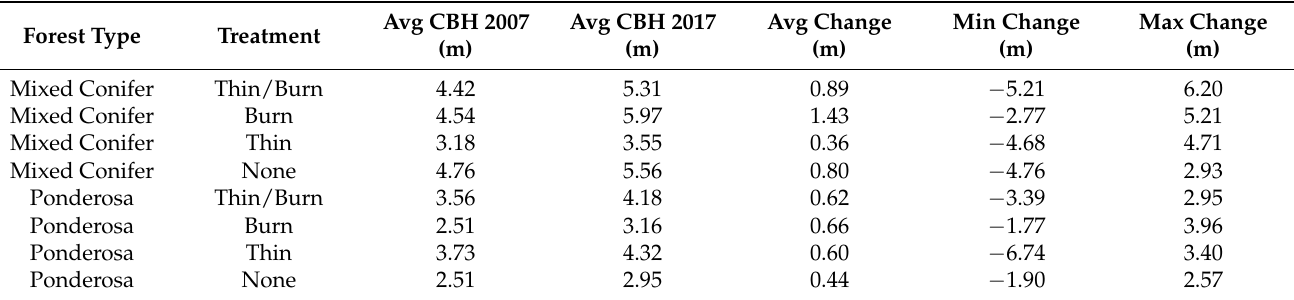
Table 2. Average Canopy Base Height (CBH) by sample stand pre-/post-treatment with average 10-year change/range.